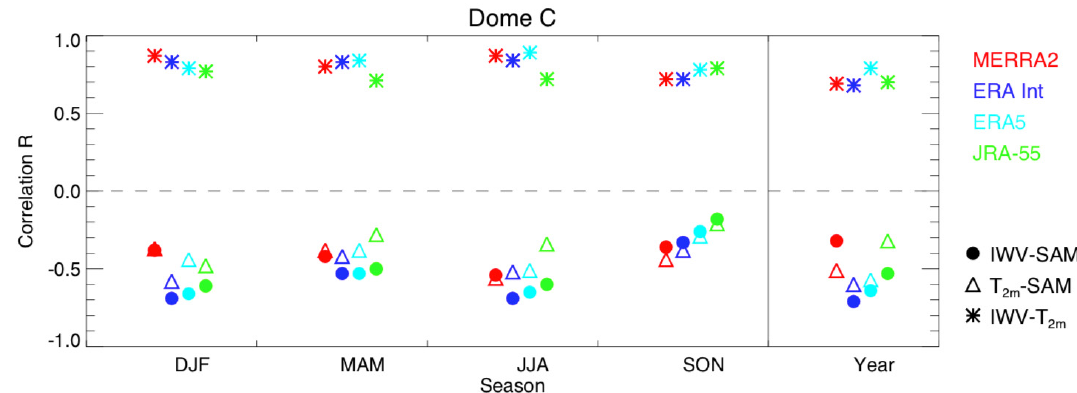
Figure 14. Linear Pearson correlation coefficient R between IWV and SAM index (filled circles), near-surface temperature and SAM index (triangles) and IWV and near-surface temperature (stars) for the MERRA2 (red), ERA Int (dark blue), ERA5 (light blue) and JRA-55 (green) data sets at Dome C, over